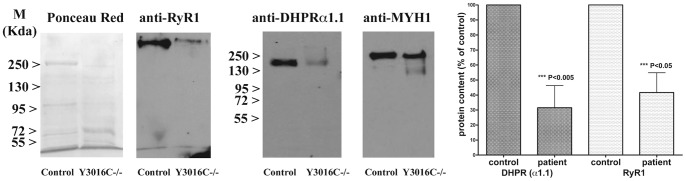
Effect of the pY3016C mutation on RyR1 protein expression on patient and control muscle biopsies.The western blot shows a dramatic decrease of the RyR1 protein and of the DHPRalpha 1.1 expression in the patient’s biopsy compared to control’s biopsy (P<0.05). Protein expression levels were quantified by densitometric analysis and normalized to the expression of myosin heavy chain. The bar plot on the right shows the mean % protein content (± SEM; of 3 different western blots) in biopsies from a control and patient Y3016C−/− (P<0.05 by the Student t test).